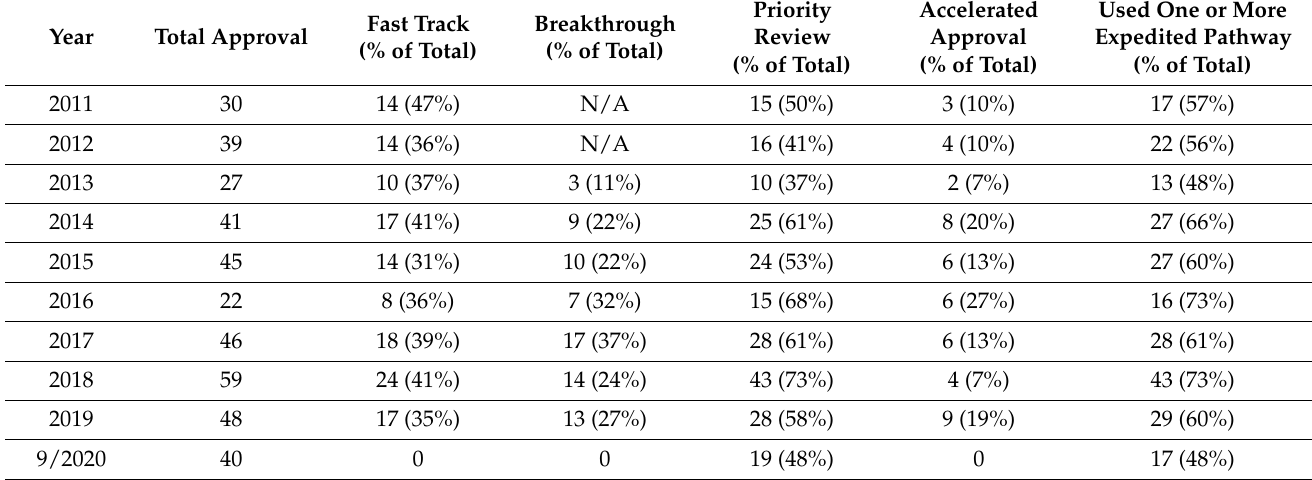
Table 1. Expedited novel drug approvals by CDER in 2011–2020.